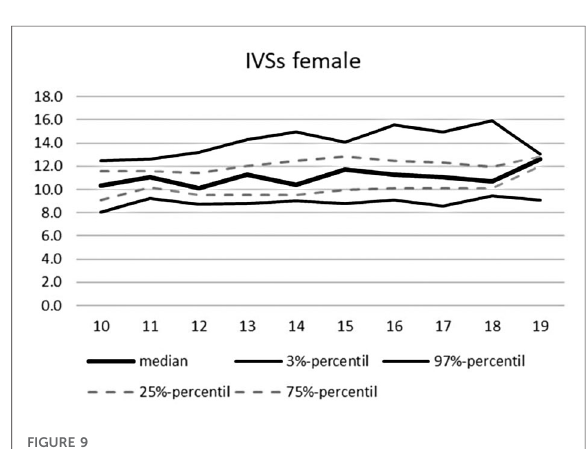
FIGURE 9 Echocardiographic values in dependence of age, IVSs